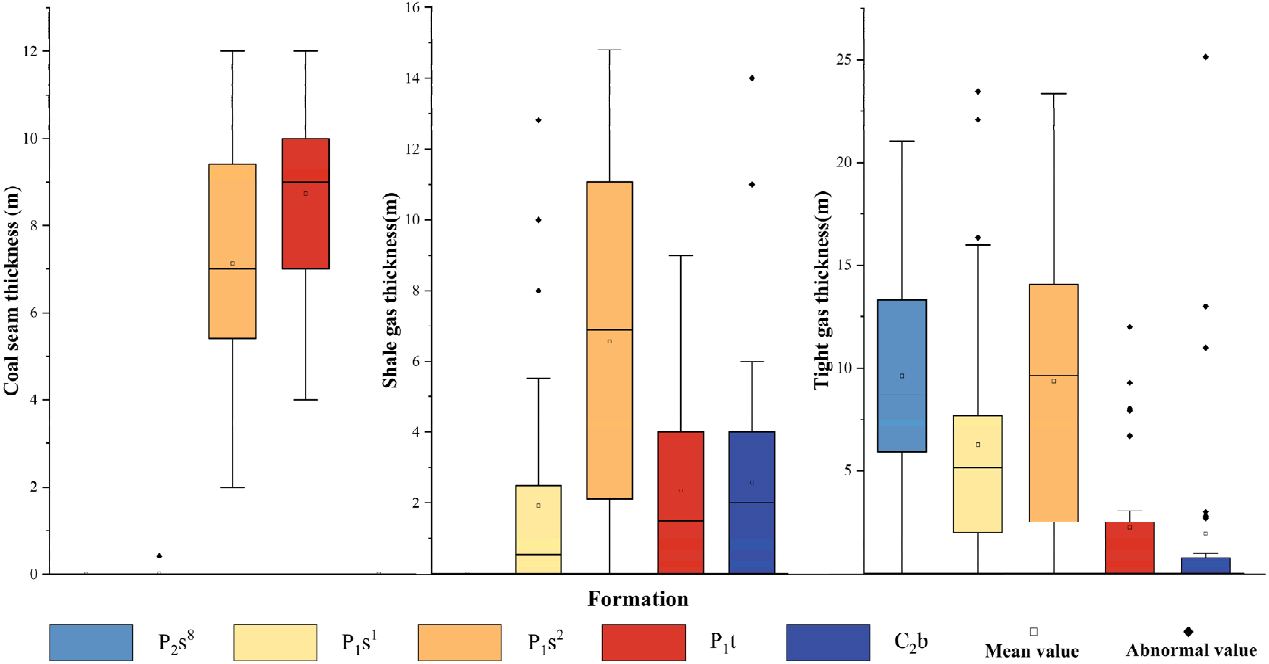
Figure 5. Development of different coal measure gas